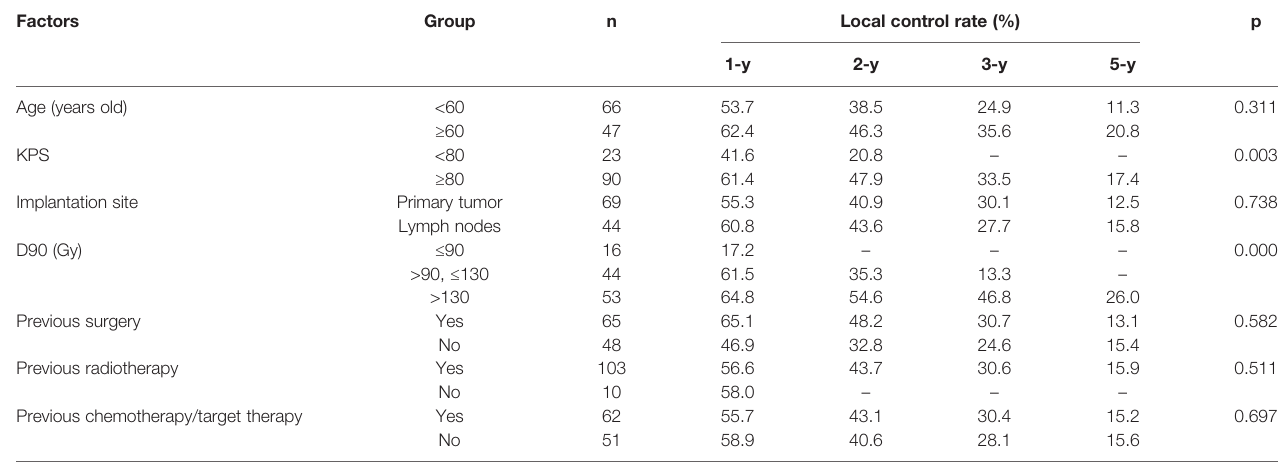
TABLE 3 | Subgroup analysis of tumor